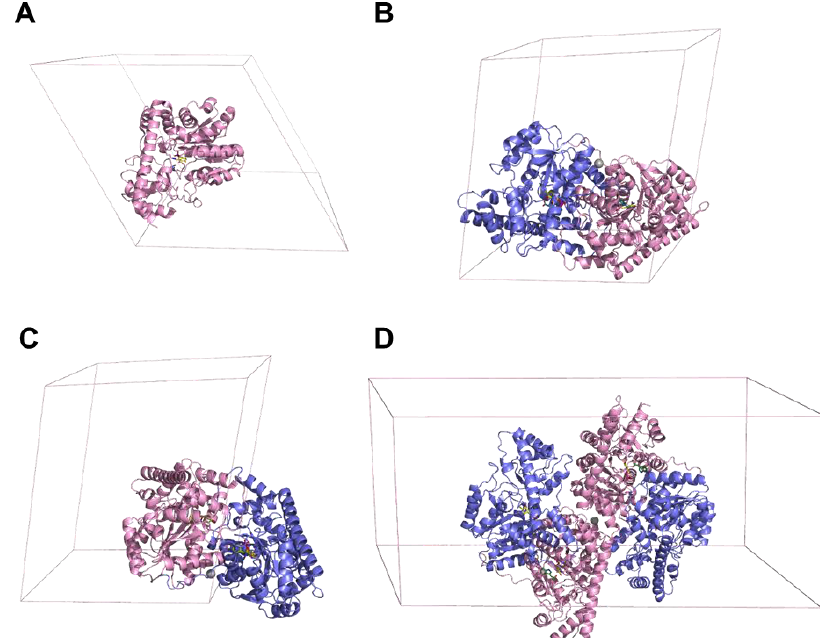
Figure 4. Unit cells and asymmetric units (ASU) of Psy ArAT complexes. ( A ) Psy ArAT/DOH (P6 5 22), monomer; ( B ) Psy ArAT/FOH (P2 1 ), dimer; ( C ) Psy ArAT/YOH (P2 1 ), dimer and ( D ) Psy ArAT/WOH (C2), two dimers.